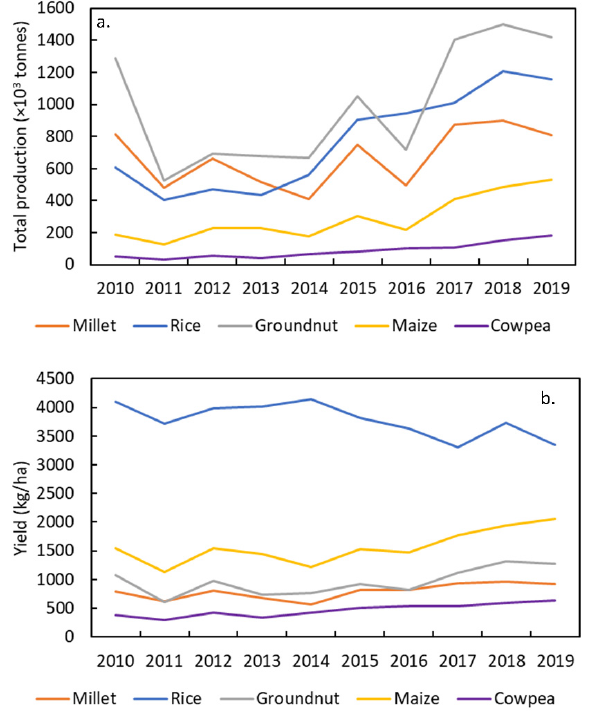
Figure 5. The total production of major crops ( a ) and their productivity ( b ) in Senegal for the period of 2010–2019 [47]. Table 1. Quantities and values of key livestock products traded in Senegal during the period of